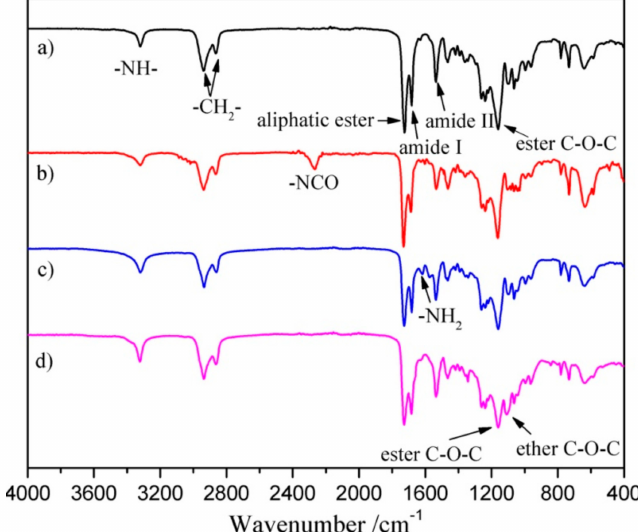
Figure 2. FT-IR spectra of ( a ) SPEU; ( b ) SPEU-NCO; ( c ) SPEU-NH 2 ; and ( d ) SPEU-PEG-a films.